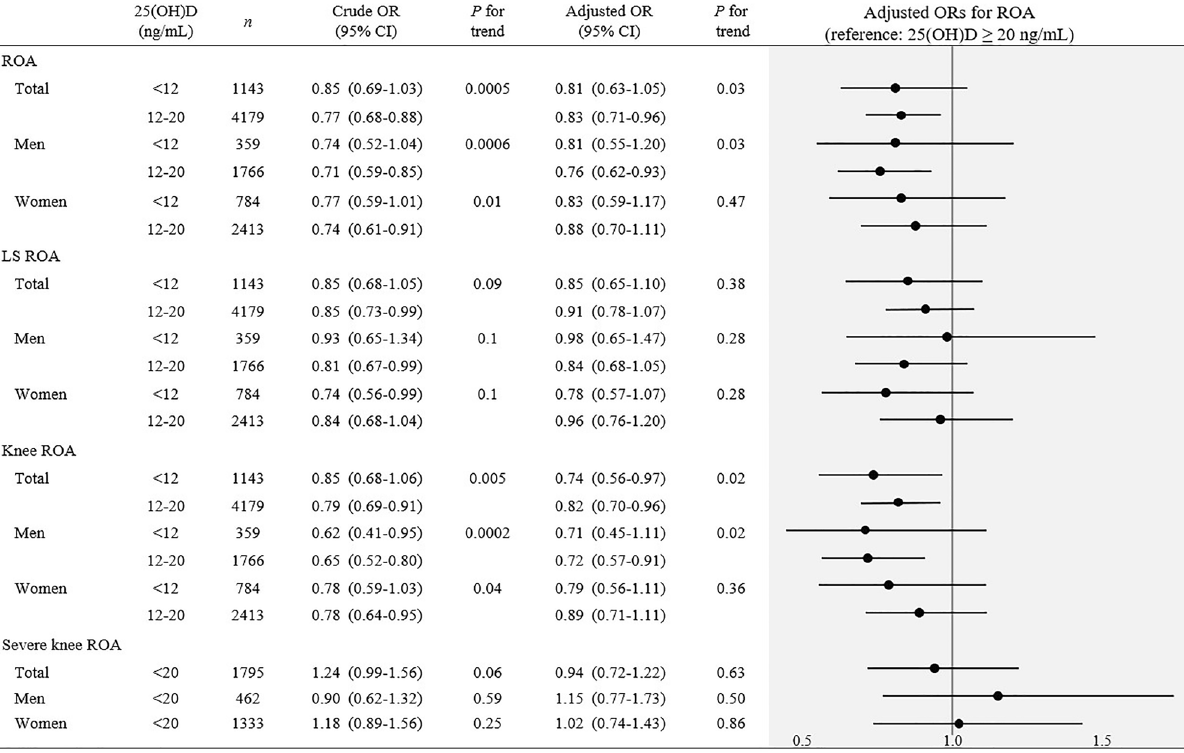
age, income, education level, longest job, physical activity, smoking status, alcohol consumption, body mass index, season of blood draw, survey year, and menopausal status (women). Weights were applied according